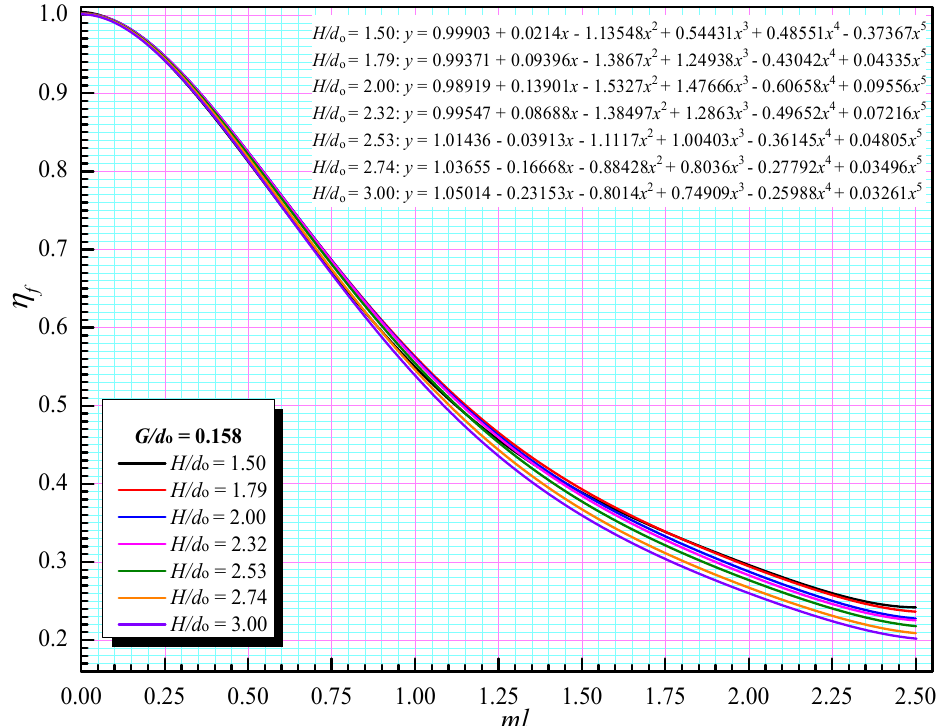
Figure 6. Linear nomograms and fitting formulae of fin efficiency at G / d o = 0.158.